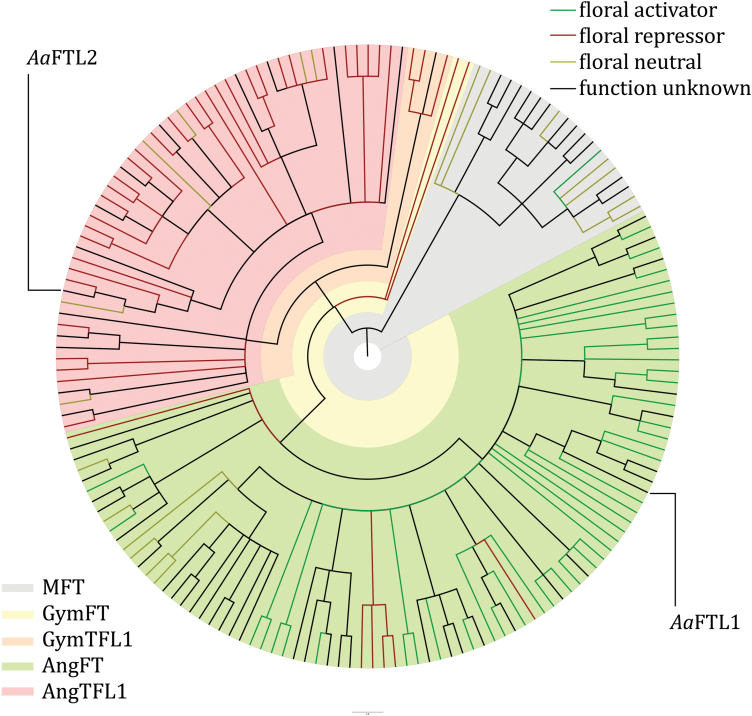
Phylogenetic tree of plant PEBPs. Cladogram of 172 PEBP sequences from 33 species belonging to 16 families of plants, inferred using a maximum likelihood method (Phyml); branches with <85% support were collapsed. Shading indicates the major clades: MFT (grey), gymnosperm FT (yellow), gymnosperm TFL1 (orange), angiosperm FT (green), angiosperm TFL1 (red). Branch colour indicates floral regulator potential: floral activators are green, floral neutral proteins are yellow, floral repressors are red, and proteins with unknown function in relation to flowering time are coloured black. The positions of the A. artemisiifolia AaFTL1 and AaFTL2 are indicated.